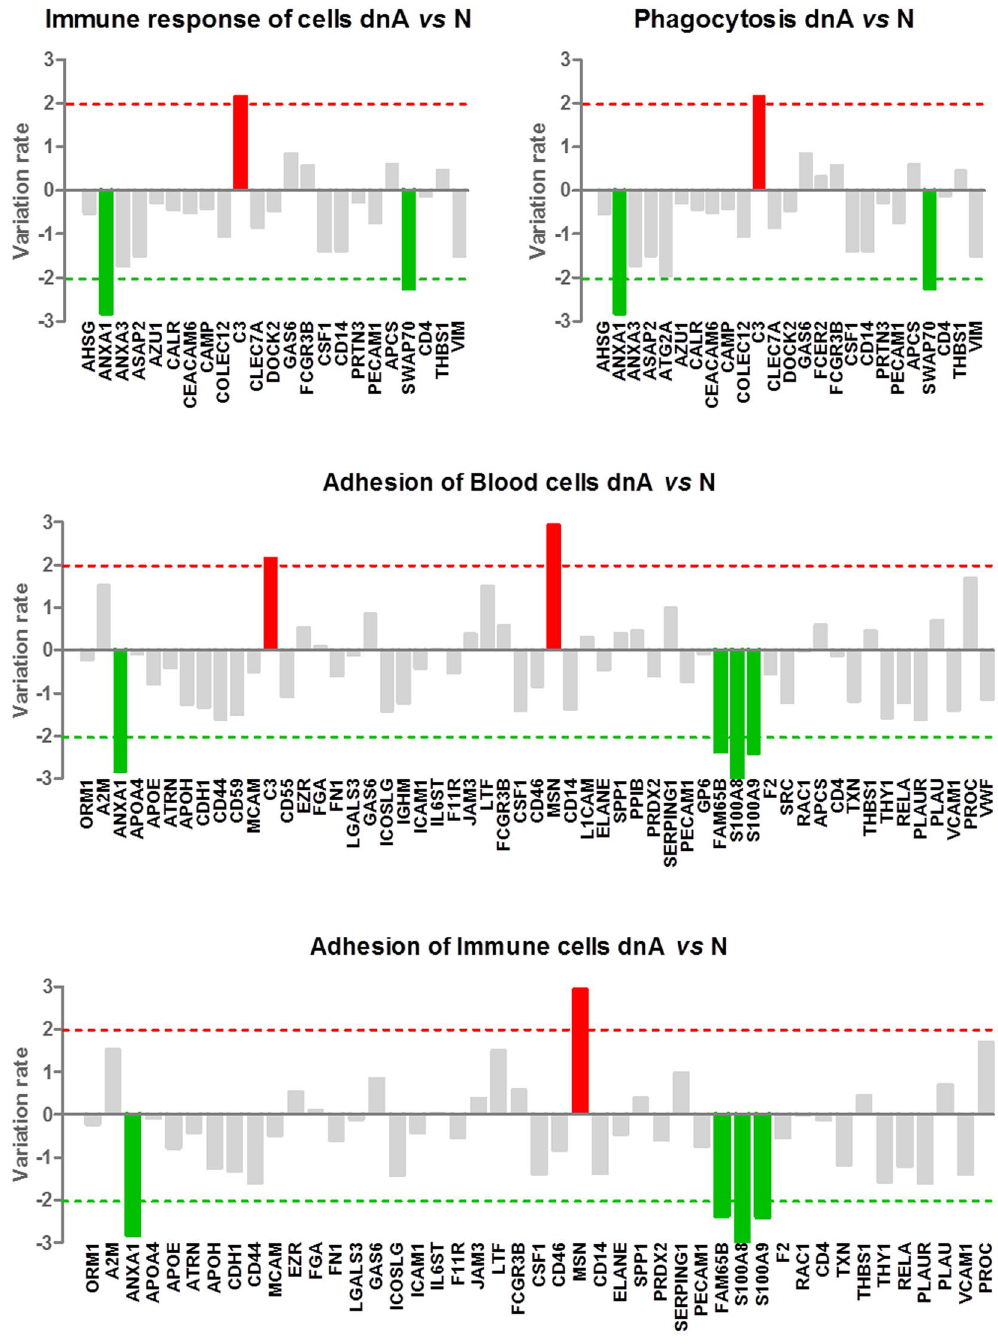
Figure 2. Functional categories related to immune response showing significant alteration between dnA and N (Z value ≥ |2|, FDR < 0.05). Variation rates for each individual protein are shown. dnA: de novo albuminuria, N: